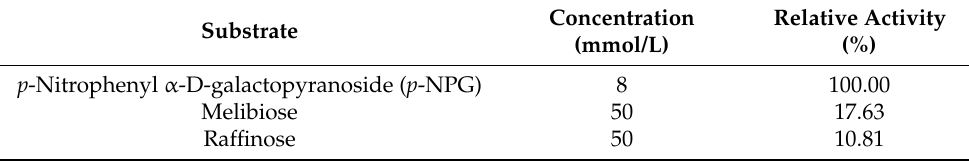
Figure 6. Reducing sugar content after treatment with α -galactosidase. ( a ) Reducing sugar content after the hydrolysis of melibiose; ( b ) Reducing sugar content after the hydrolysis of raffinose. The enzyme dosages are represented by different signals: gray square, 5 U/mL; red circle, 10 U/mL; blue triangle, 20 U/mL. 3.6.2. HPLC Analysis of the Hydrolysis During the hydrolysis of melibiose and raffinose, high-performance liquid chroma- tography (HPLC) was also used to detect the hydrolysis products. The external standard method was used to conduct a qualitative study based on the retention durations of each component. By combining the peak area of each component, the content of hydrolyzed products was determined (Figure 7). Generally speaking, under the influence of α -galac- tosidase, melibiose can be hydrolyzed to galactose and glucose, while raffinose may be hydrolyzed to galactose and sucrose. This capability is consistent with most other α -ga- lactosidases [13,18]. Then, the hydrolytic ability of α -galactosidase was confirmed by HPLC (Figures 8 and 9a–c), which was in accordance with the results of TLC. The degra- dation rate of melibiose and raffinose was calculated by the decrease in melibiose and 0